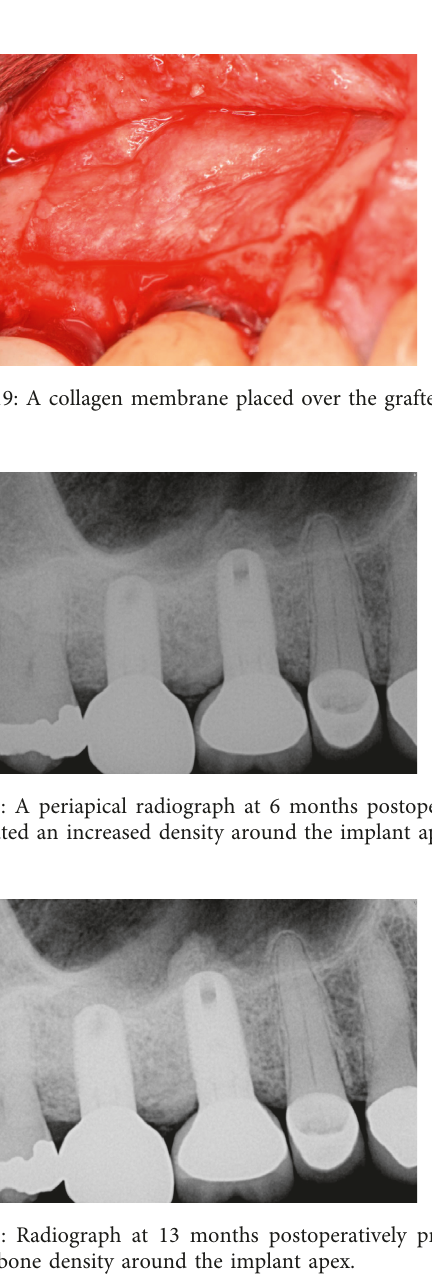
Figure 18: Mineralized cortical bone placed around the apex of the implant.